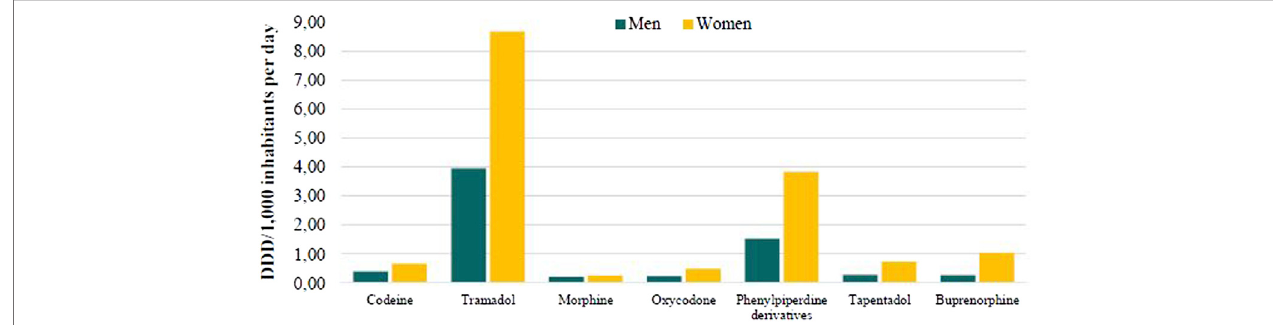
FIGURE 1 | Opioid use (DDD/1,000 inhabitants per day) by sex and type of drug in Catalonia, 2019.